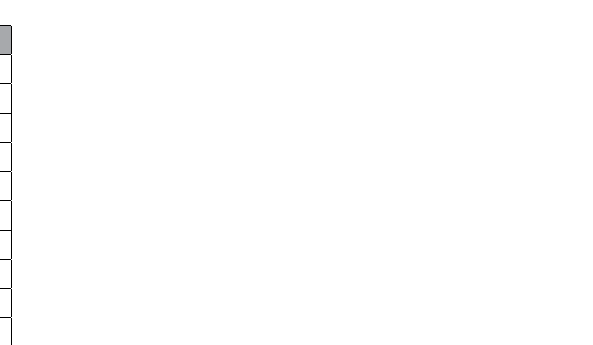
Table 4. Complications of machete cut fractures (N =